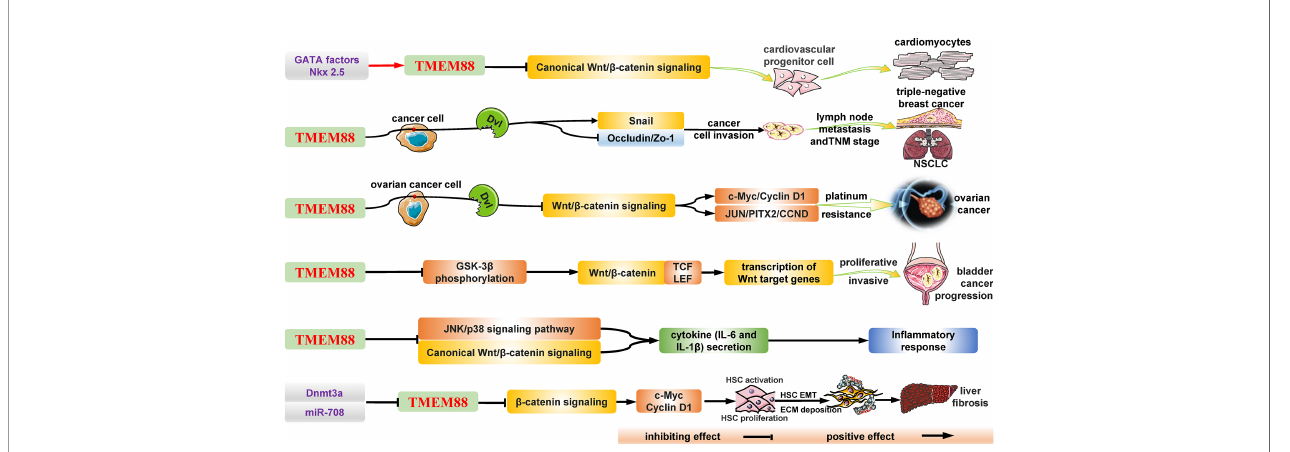
FIGURE 1 | The structure and general biological functions of TMEM88 in humans. As a secondary transmembrane protein, TMEM88 is widely distributed in many types of cells and tissues and plays an important regulatory role in various diseases and pathological processes, such as cancers, fi brosis, and in fl ammatory responses. Under stimulation, including DNA methylation, noncoding RNA and the in fl ammatory environment, the mRNA and protein levels of TMEM88 changed signi fi cantly. Subsequently, the signi fi cantly changed TMEM88 regulates the classical and noncanonical Wnt/ b -catenin signaling pathways through different mechanisms in the cytoplasm and nucleus, such as the interaction with DVL proteins, thereby affecting the transcription and expression of downstream target genes. Ultimately, these effector target molecules affect the growth and development of tissues and organs and the progression of diseases, such as tumors by regulating various cellular life activities, such as cell proliferation, migration, invasion, and drug resistance. CCND, Cyclin D1; c-Myc, c-Myc proto-oncogene; Dnmt3a, DNA (cytosine-5)-methyltransferase 3a; DVL, PDZ domain of Dishevelled-1; ECM, extracellular matrix; EMT, epithelial-mesenchymal transition; GATA, GATA transcription factor; GSK-3 b , glycogen synthase kinase-3 b ; HSC, hepatic stellate cell; JNK, c-Jun N-terminal kinase; JUN, jun proto-oncogene; NSCLC, non- small-cell lung cancer; PITX2, paired-like homeodomain 2; TCF/LEF, T-cell factor/lymphoid enhancer-binding factor; TMEM88, transmembrane protein 88; TNM, tumor node metastasis.